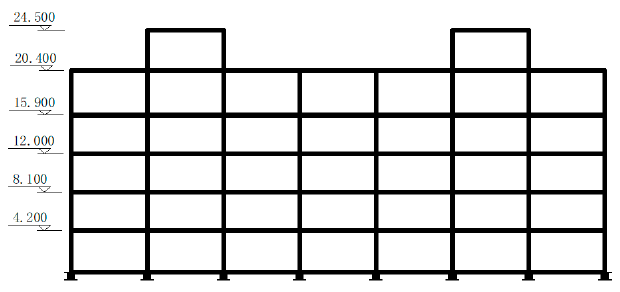
Figure 7. Front elevation of building (m).